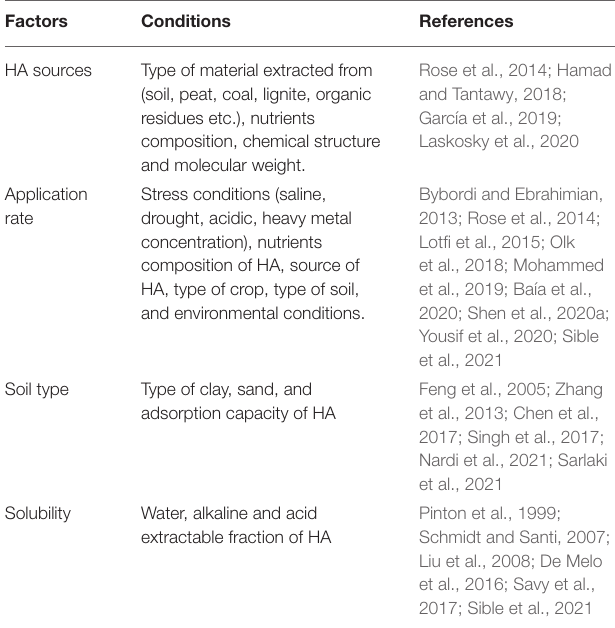
TABLE 3 | Factors and conditions that affect humic acids (HA)